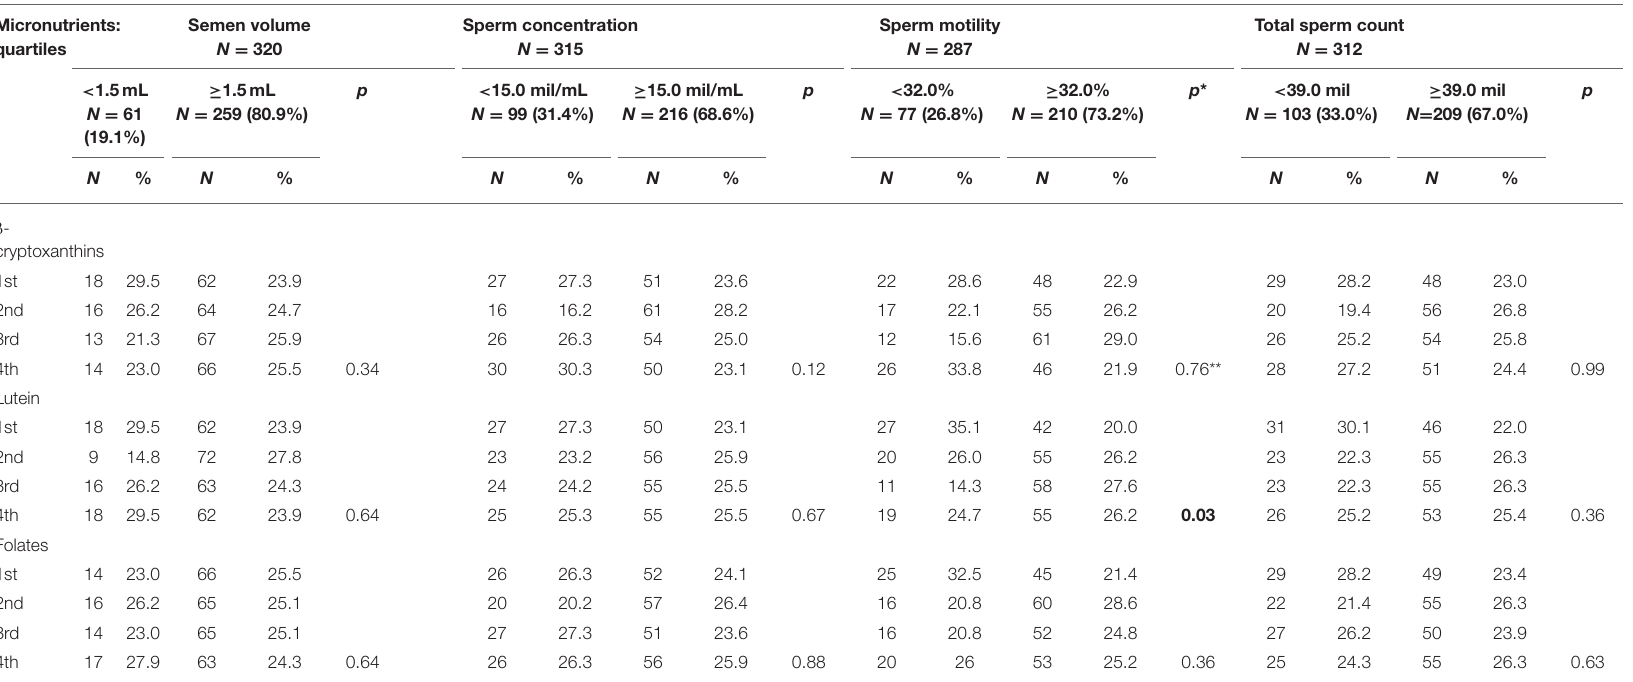
* Mantel-Hanszel chi-square; ** heterogeneity chi-square p = 0.04. The bold values indicates p <